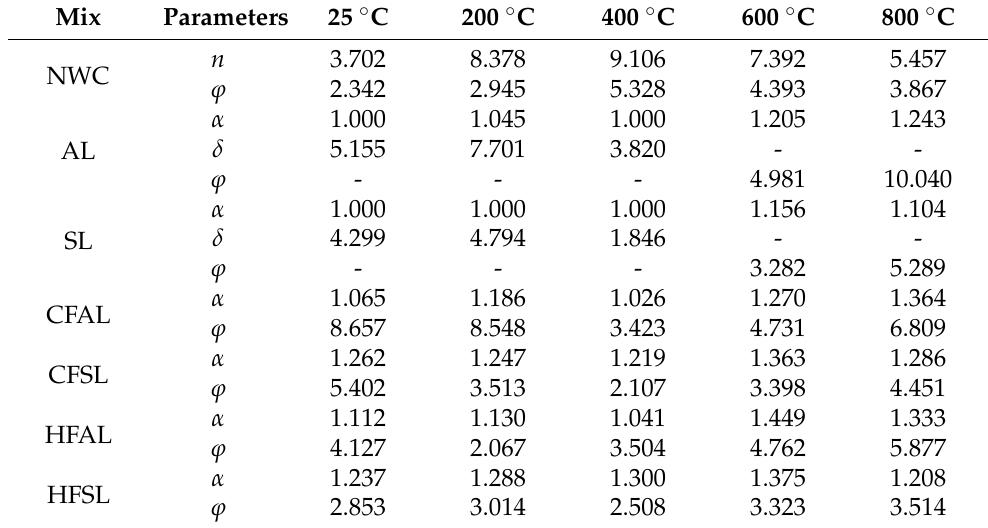
Table 7. Regression parameters n , δ , α , and ϕ